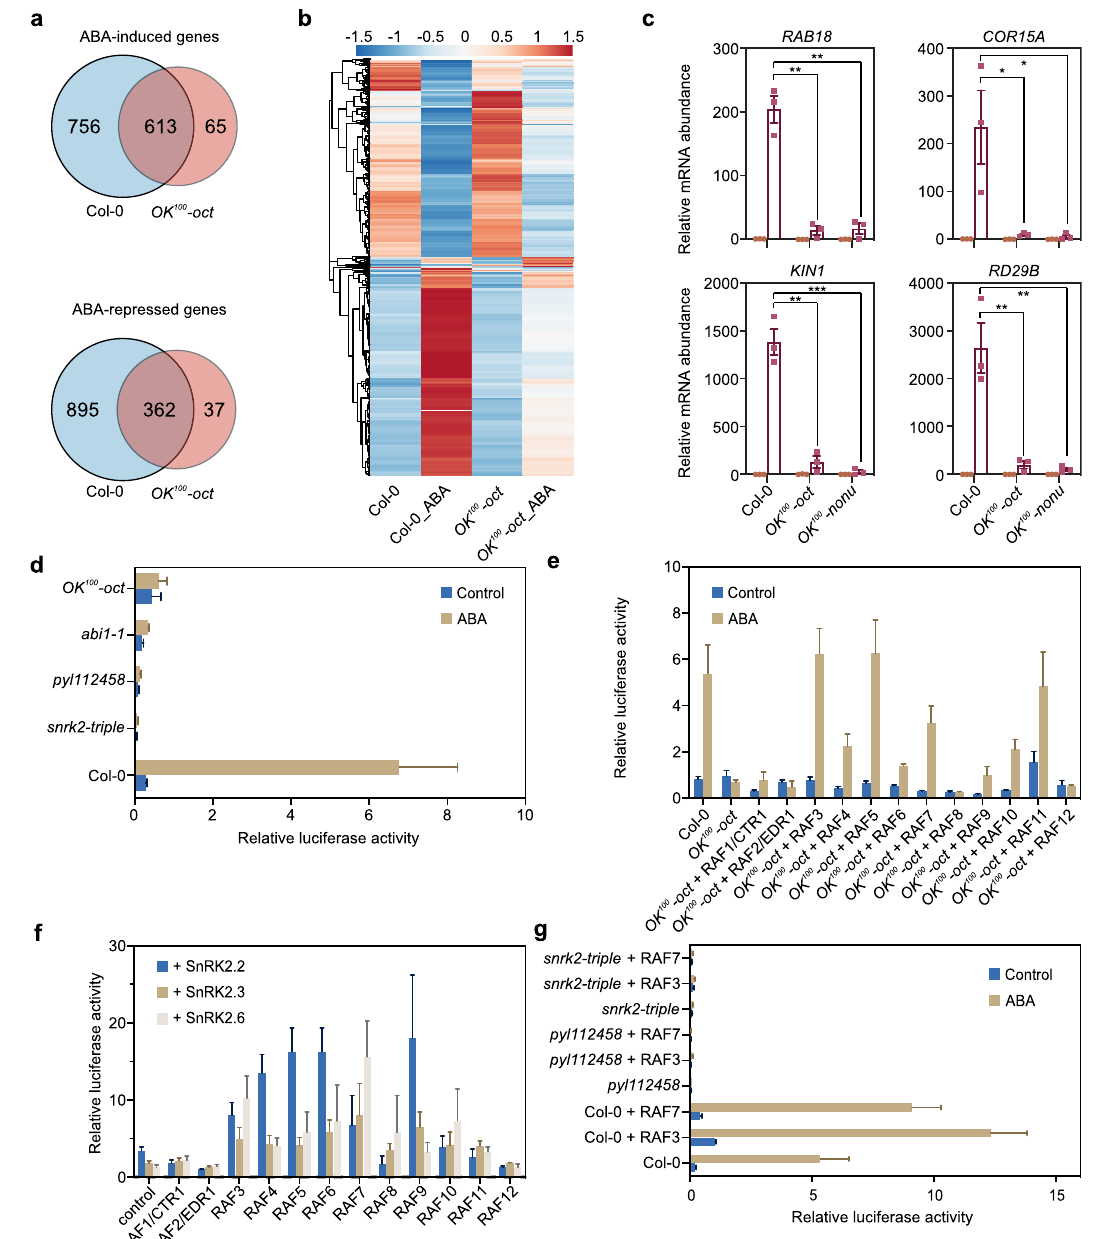
Fig. 5 B2 and B3 RAFs are required for ABA-induced gene expression. a Venn diagrams showing the overlaps of ABA-induced and ABA-repressed genes in the wild type and OK 100 -oct seedlings. b Heat map showing the expression levels of ABA-responsive genes in wild type and OK 100 -oct seedlings. c Expression of the ABA-inducible marker genes in wild type, OK 100 -oct , and OK 100 -nonu seedlings after 6 h of ABA treatment. Error bars, SEM ( n = 3 biological replicates). Two-tailed paired t -tests, * p < 0.05, ** p < 0.01, *** p < 0.001. d The activation assay of the ABA-responsive RD29B-LUC reporter gene in wild type and mutants. The protoplasts were transformed with the reporter plasmid and incubated with or without 5 µ M ABA for 5 h under light. Error bars, SEM ( n = 3 individual transfections). e Add-back assay testing RAF1 to RAF12 in activating the reporter gene in the protoplasts of OK 100 -oct . Error bars, SEM ( n = 4 individual transfections). f Activation of the reporter gene by the combinations of RAFs with SnRK2.2, SnRK2.3, or SnRK2.6 in the protoplasts of OK 100 -oct . The ratio of RD29B-LUC expression in the protoplasts with 5 µ M ABA relative to that without ABA treatment was used to indicate the activation activity of RAF-SnRK2 pairs. Error bars, SEM ( n = 4 individual transfections). g Activation of the reporter gene by RAF3 or RAF7 in the protoplasts of wild type, pyl112458 , or snrk2-triple . Error bars, SEM ( n = 3 individual transfections). Source data are provided as Source Data fi